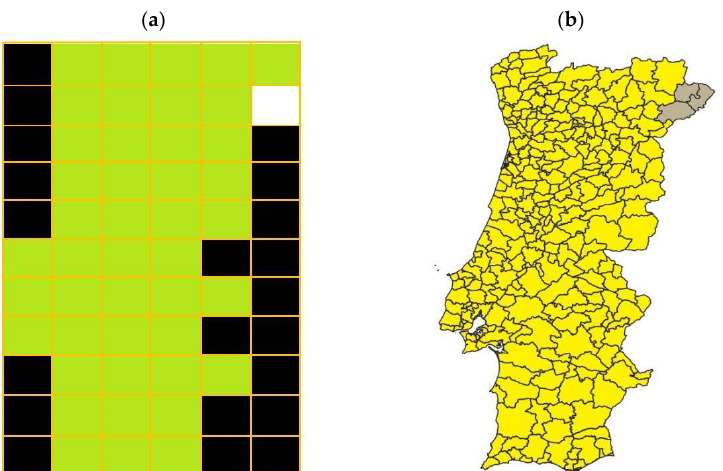
Figure 3. ( a ) Cell grid representing the Portuguese mainland where, according to the simulation, termites existed in 2001. Each cell was defined according to termite presence (green) or absence (white) or to its being outside the Portuguese mainland territory (black). ( b ) Portuguese mainland counties where termite existence is predicted to have existed, according to the simulations, in 2001. Termite presence is indicated in yellow, and their absence in grey.